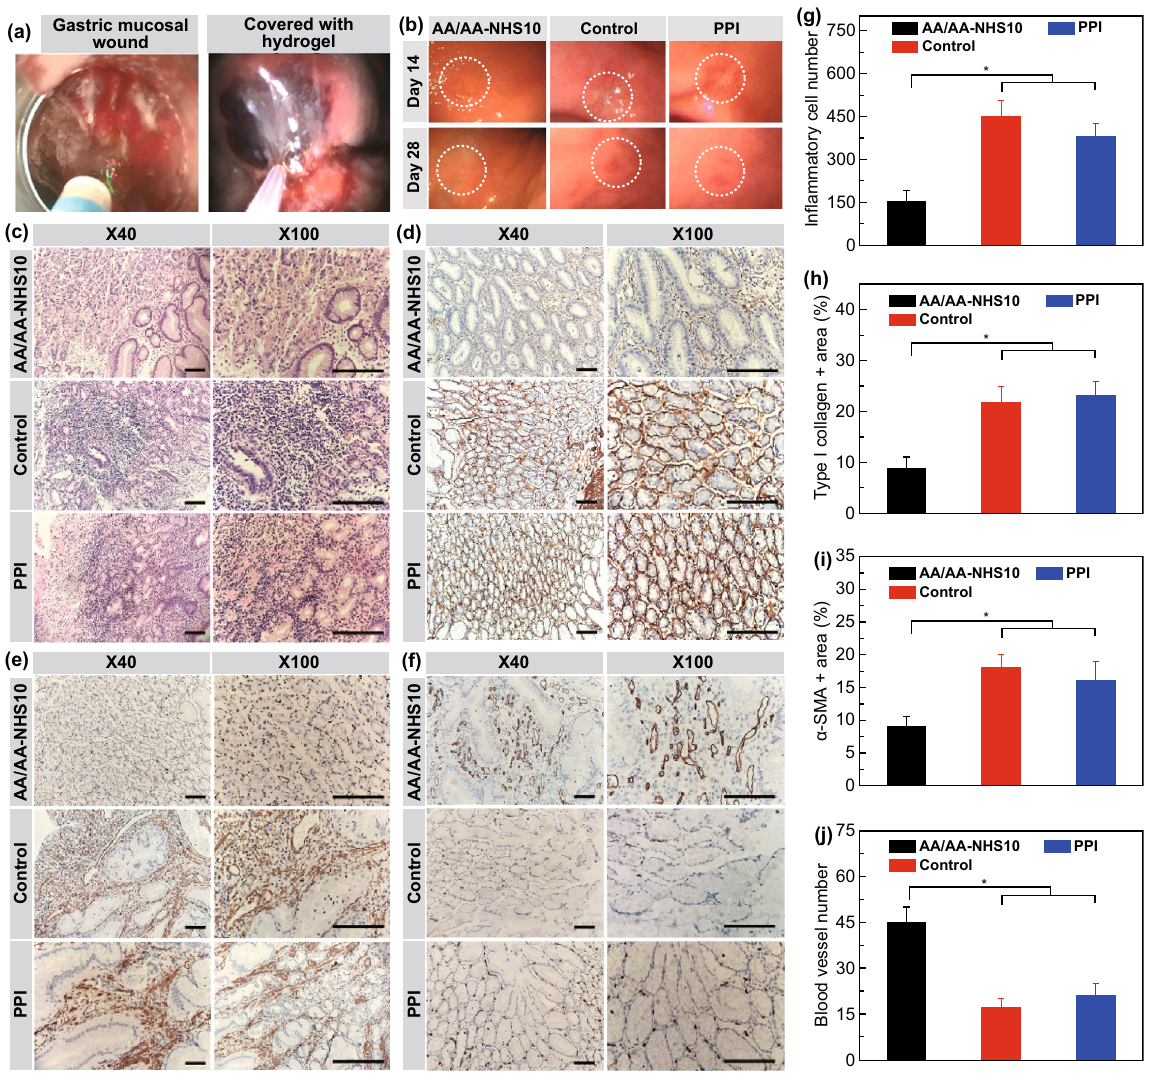
Fig. 6 The wound healing performance of the AA/AA-NHS10 hydrogel in the swine gastric ESD model. a Investigation protocol diagram. b Healing status of the gastric wound on AA/AA-NHS10 hydrogel endospray-treated, esomeprazole-treated and control swine on days 14 and 28. The white circle indicates the wound area. c H&E staining and immunobiological staining of d type I collagen, e α-SMA, and f CD34 in wound tissue sections from AA/AA-NHS10 hydrogel endospray-treated, esomeprazole-treated and control swine after 28 days. Semi-quantification of the inflammatory cells in g H&E, h type I collagen, i α-SMA, and j micro-blood vessels in wound tissue sections from AA/AA-NHS10 hydrogel endospray-treated, esomeprazole-treated and control swine after 28 days ( n = 4). Scale bar: 400 µm. * P < 0.05, ** P <